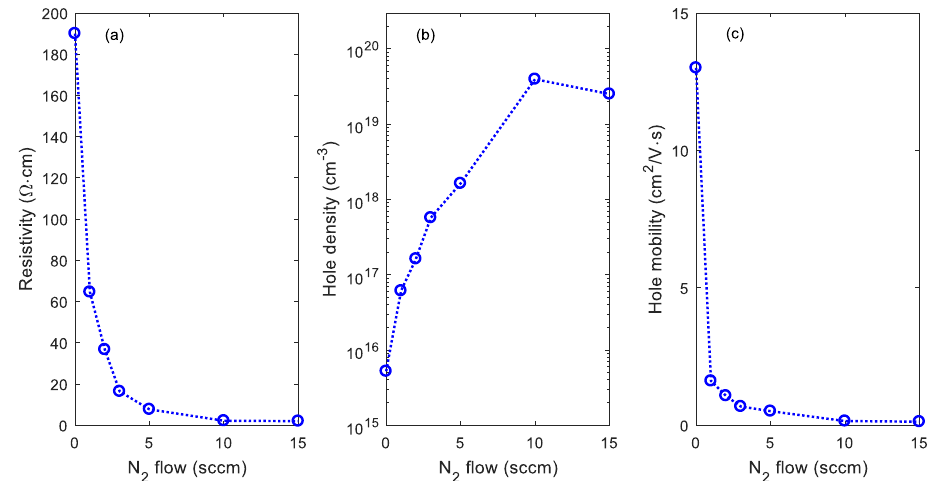
Figure 5. ( a ) Film resistivity, ( b ) majority carrier (hole) density, and ( c ) majority carrier (hole) mobility versus N 2 gas flow rate for N:Cu 2 O thin films on quartz.